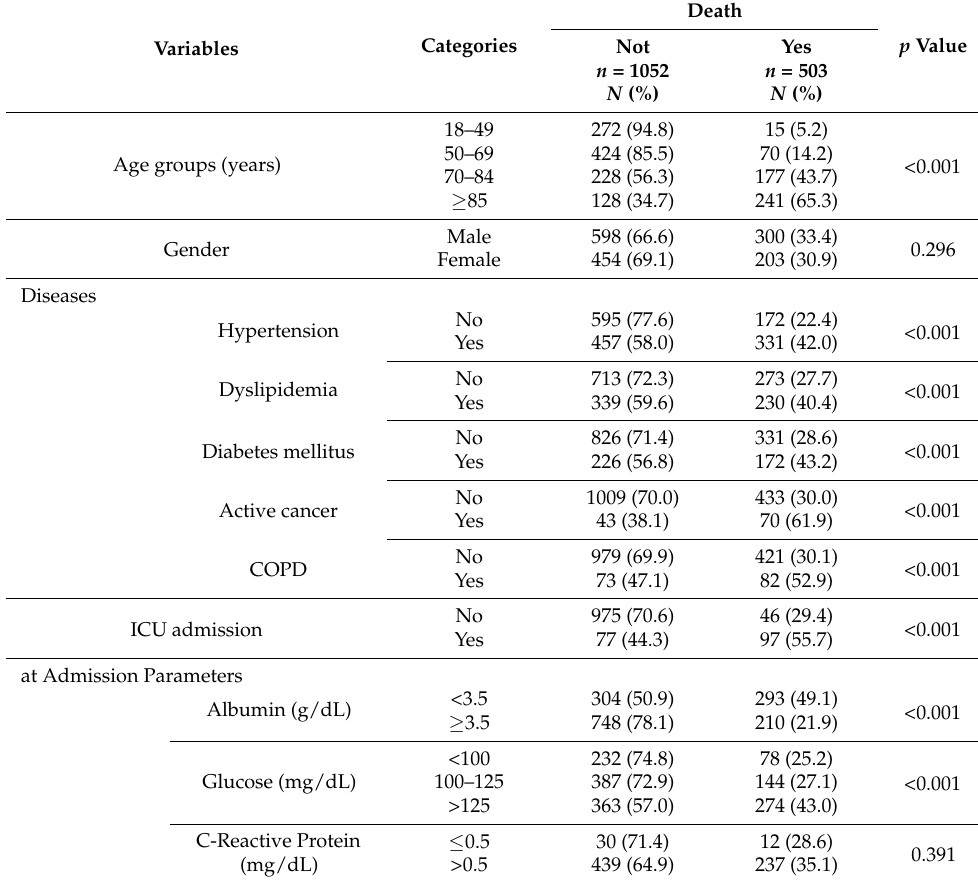
Table 2. Mortality rate (%) according to demographic and clinical variables in the multi-center cohort- study on the impact of admission serum albumin levels for the prediction of <30 days in-hospital all-cause mortality in COVID-19 patients, Spain, August–November 2020 ( n =